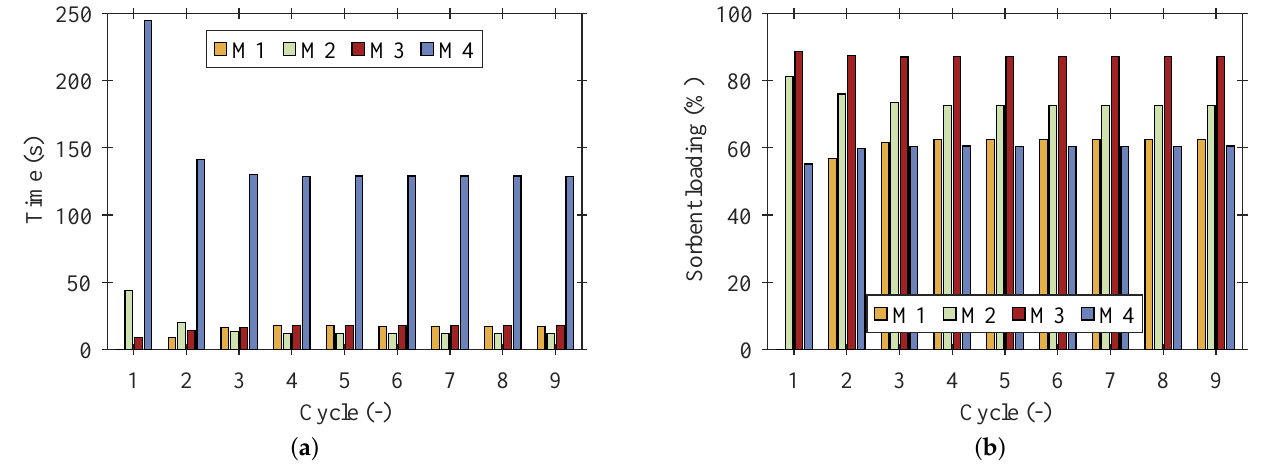
Figure 10. Cyclic operation in six reaction chambers; results shown for nine cycles in chamber 1. ( a ) Time span of the modes depending on the cycle number, and ( b ) relative sorbent loading at the end of the